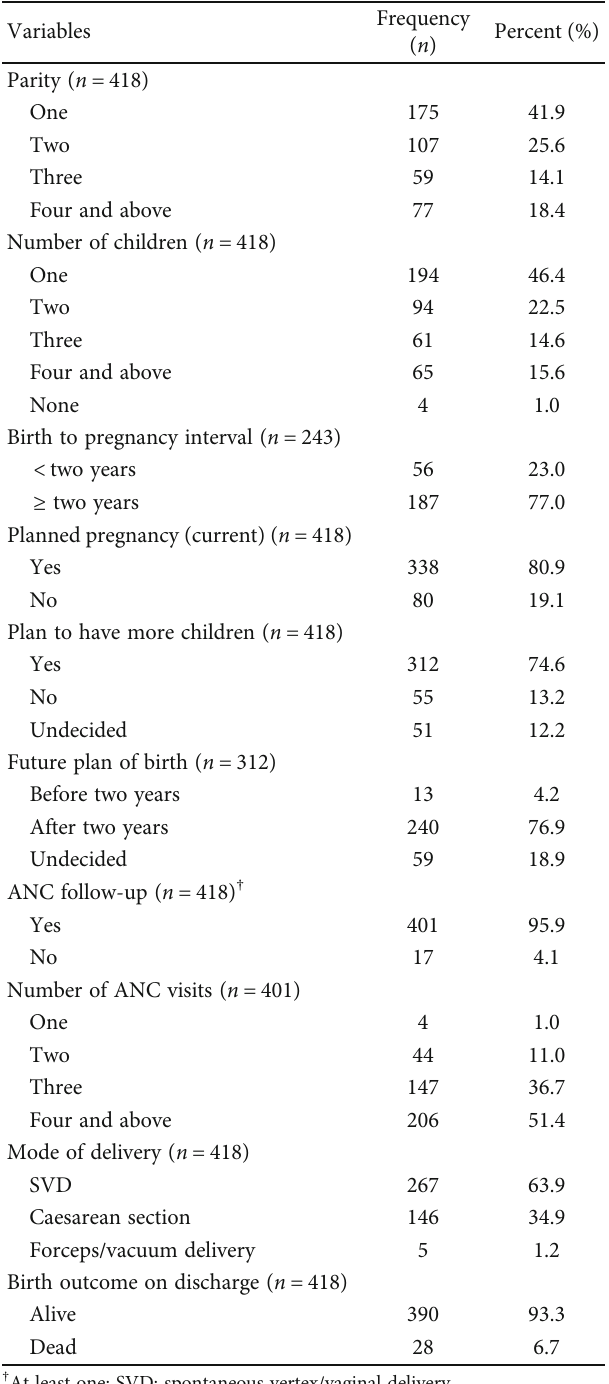
Table 2: Obstetric pro fi le of respondents in HUCSH, Ethiopia, April